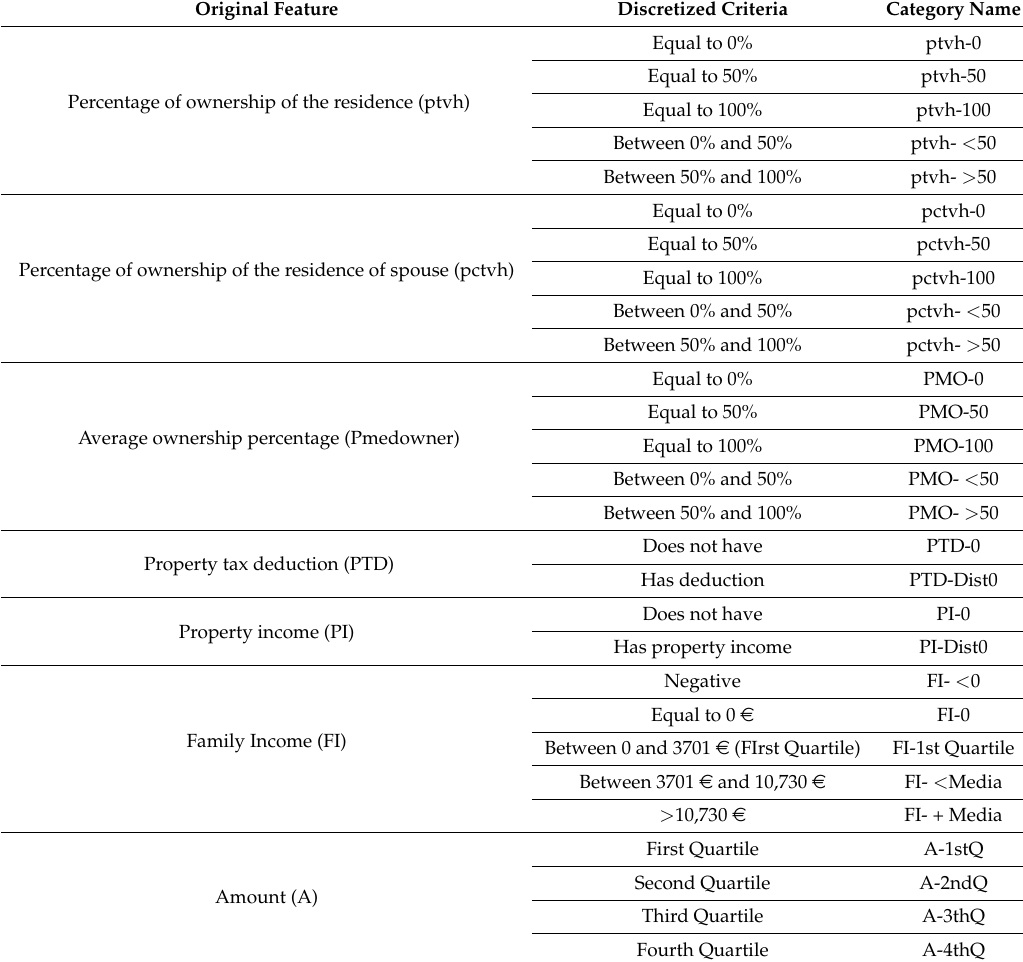
Table 3. Discretized criteria for the IEF semi-synthetic